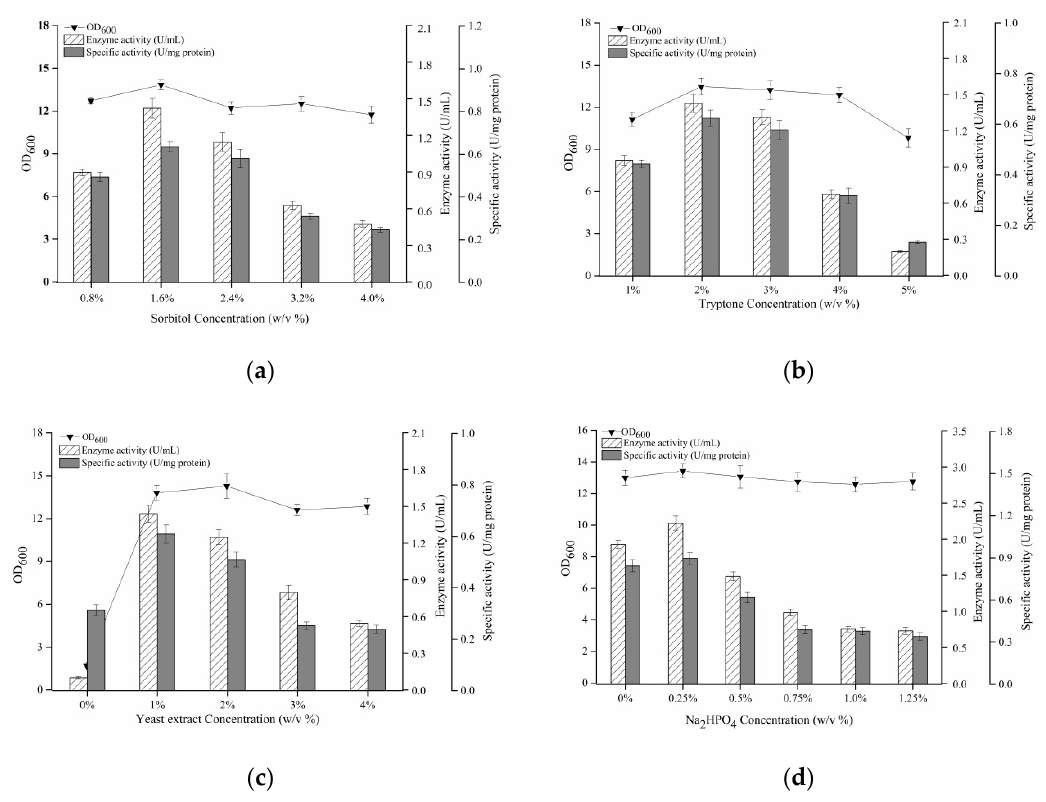
Figure 7. Effect of medium components concentration on cell growth and enzyme activity. ( a ) Effect of sorbitol. ( b )Effect of tryptone. ( c ) Effect of Oxoid yeast extract. ( d ) Effect of Na 2 HPO 4 .